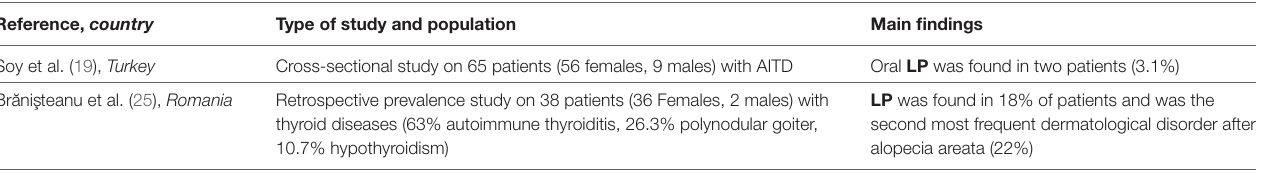
TAbLe 2 | Studies reporting clinical and/or laboratory data about subjects affected by AITD who were found positive for lichen. Reference, country Type of study and population Main